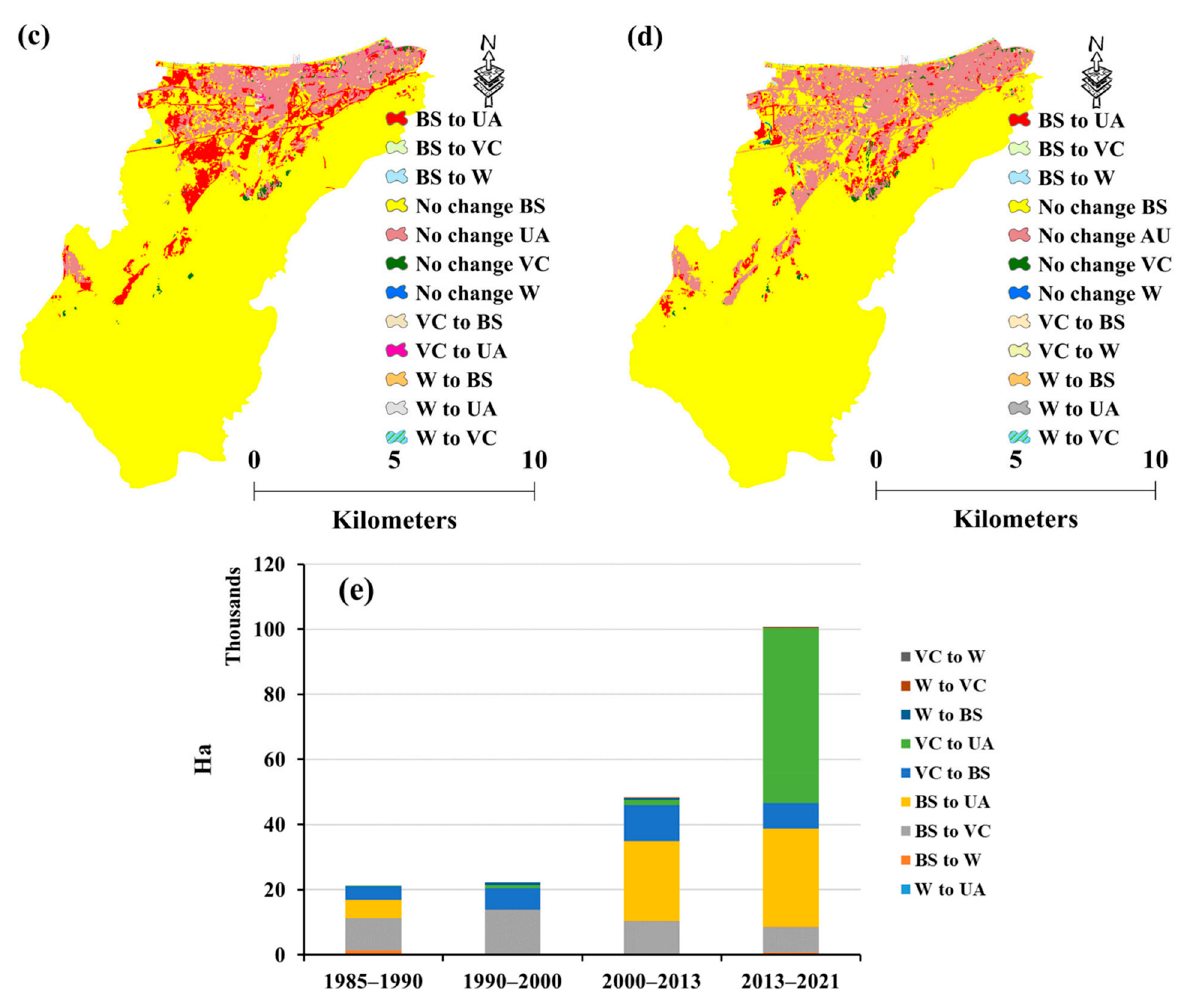
Figure 4. LULC in Bawsher ( a ) 1985–1990, ( b ) 1990–2000, ( c ) 2000–2013, ( d ) 2013–2021, and ( e ) the overall LULC changes for 1985–2021 (BS = Bare; VC = Vegetation Cover Soil; UA = Urban Area; W = Water).